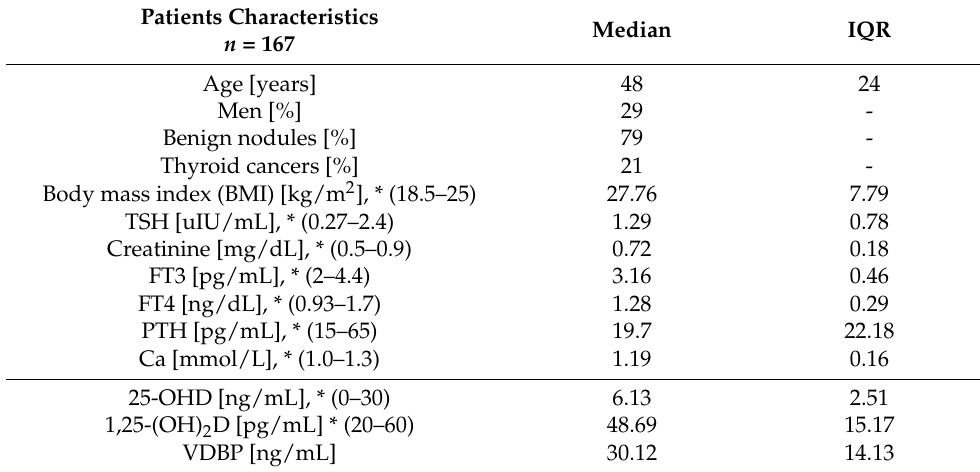
Table 4. Patient characteristics before thyroidectomy procedure. Patients